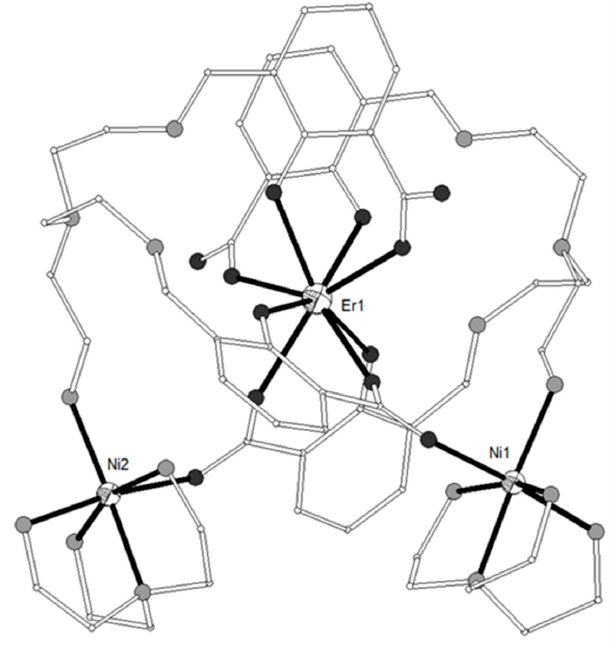
Figure 11. The molecular structure of the cation [{Ni(H 2 L 20 )(tren) 2 } 2 Er] 3+ in complex 96 . Color code as in Figure 2 [41].